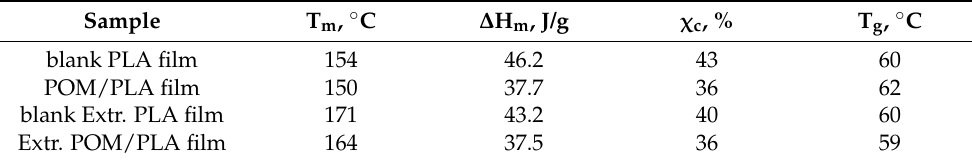
Table 3. Thermal properties of PLA with POM